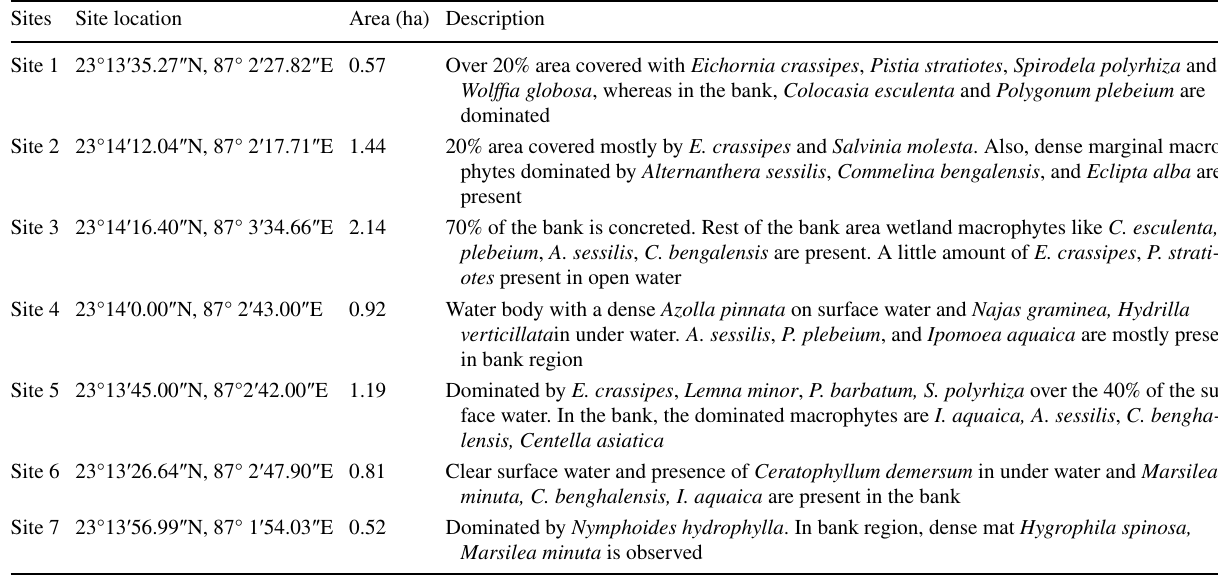
Table 1 A brief description of seven selected study sites Sites Site location Area (ha)